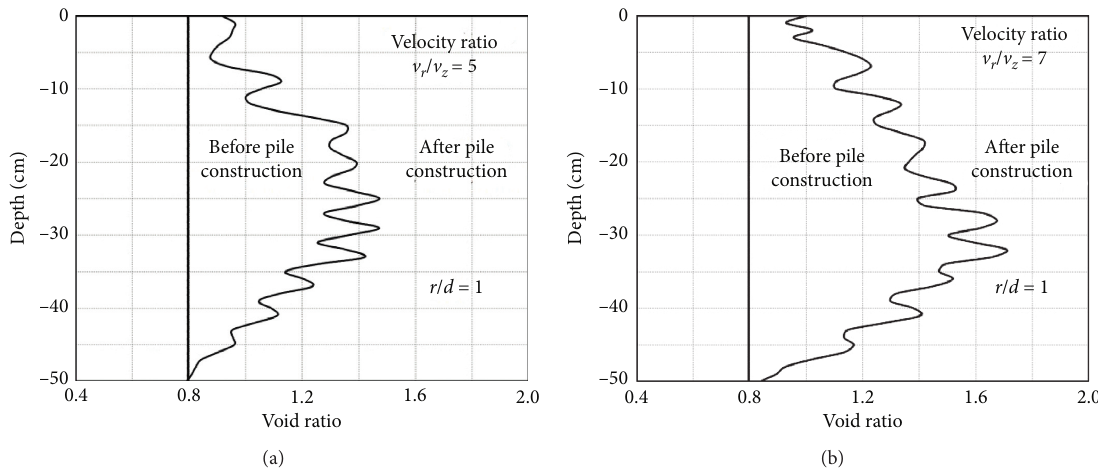
Figure 11: Changes of the void ratio of the soil at a distance of 1d to the drilling